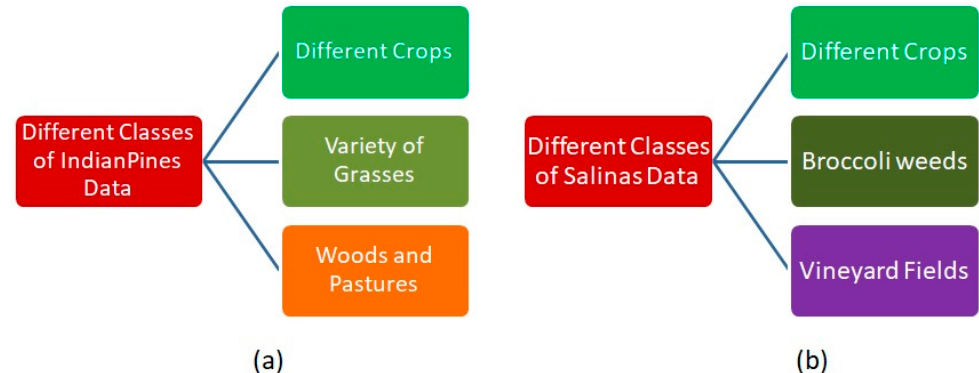
Figure 3. Different classes of AVIRIS Sensor data ( a ) Indian Pines ( b ) Salinas.